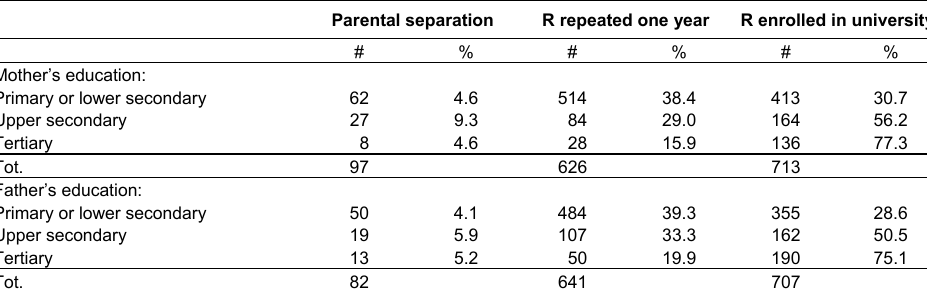
Table 2 : Parental separation by parents’ education Parental separation R repeated one year R enrolled in university # % # % # % Mother’s